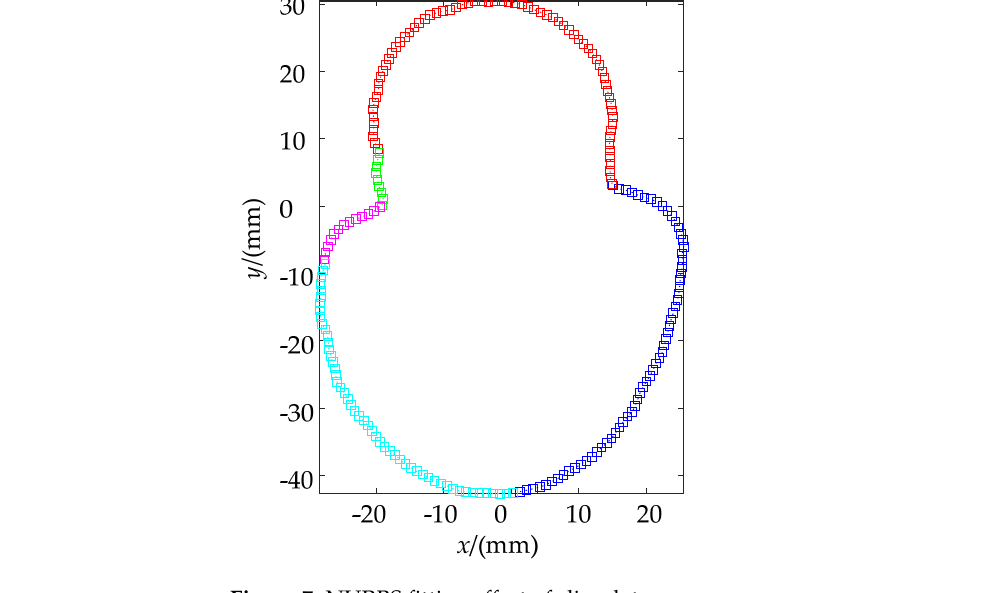
Figure 7. NURBS fitting effect of slice data.